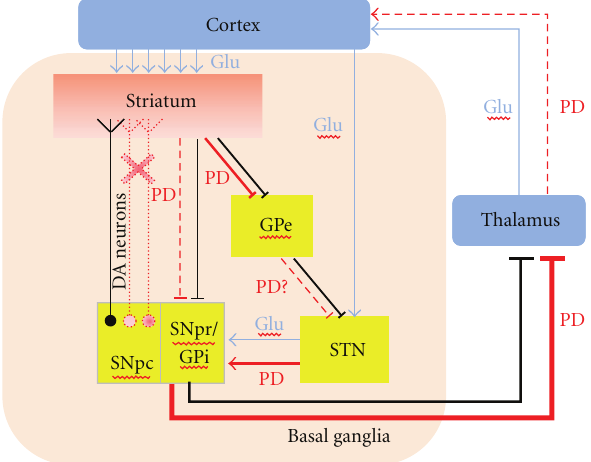
Figure 1: Basal ganglia motor circuit in Parkinson’s disease: dopaminergic neurons (DA) create a direct pathway between Substantia Nigra pars compacta (SNpc) and striatum—the input nuclei of the basal ganglia. Another direct pathway connects the striatum to the internal segment of globus pallidus (GPi) and the substantia nigra pars reticulata (SNpr). GPi and SNpr are the output nuclei of the basal ganglia, which projects to the thalamus and from there to the cortex. The indirect pathway connects the striatum to output nuclei through external segment of the globus pallidus (GPe) and then subthalamic nucleus (STN). In Parkinson’s disease (PD), the dopaminergic input from SNpc is progressively lost, causing a reduction in the direct pathway signal. Indirect pathway increases its activity through STN in the output nuclei and has inhibitory influence on the thalamus. It leads to a reduction of thalamic glutamateric input on the motor cortex and subsequent reduction in movement, as rigidity and bradykinesia are observed in PD